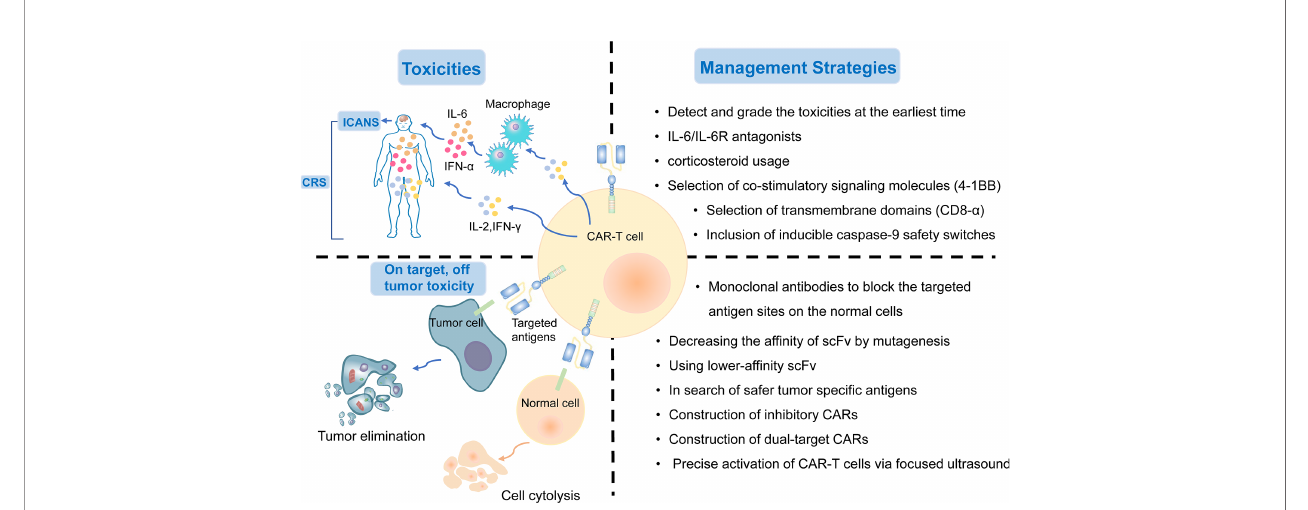
FIGURE 4 | The treatment-related and on-target, off-tumor toxicities and corresponding management strategies of CAR-T cell therapy.